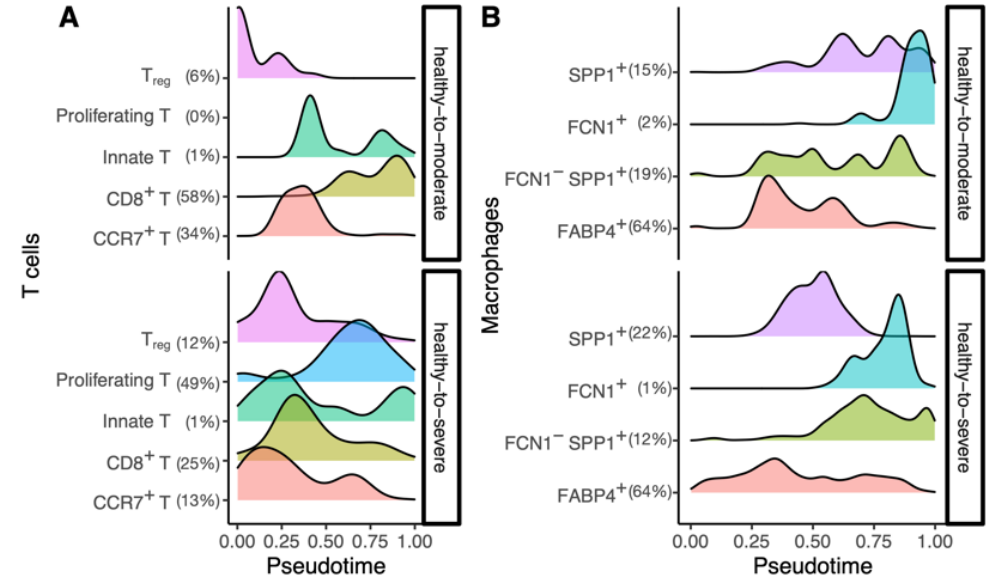
Figure 2. Changes of sub-cell type populations for each inferred cellular trajectory. ( A ) T cell sub-cell type changes of healthy-to-moderate (top) and healthy-to-severe (bottom). ( B ) Macrophage sub-cell type changes of healthy-to-moderate (top) and healthy-to-severe (bottom). The x -axis indicates the inferred pseudotime, and the y -axis indicates the height of density estimated and visualized by the geom_density function of ggplot2 R package [25]. A percentage next to a cell type name indicates the proportion of the cell type in the trajectory, and it is rounded to the ones place. Treg: regulatory T cells. CD8: cluster of differentiation 8. CCR7: C-C motif chemokine receptor 7. SPP1: secreted phosphoprotein 1. FCN1: Ficolin-1. FABP4: Fatty acid-binding protein